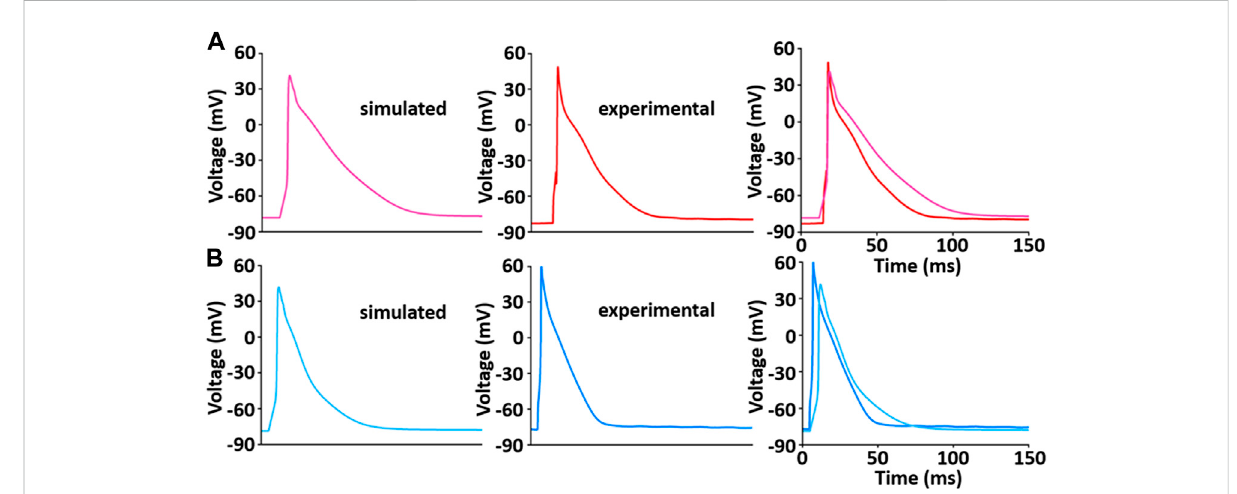
FIGURE 9 Model-generatedLV (A) andRV (B) APsat1 Hzand 22 ° C(Kim, 2018). EachsimulatedAPs was validated with experimentallyrecorded LV (A) and RV (B) APs, respectively.